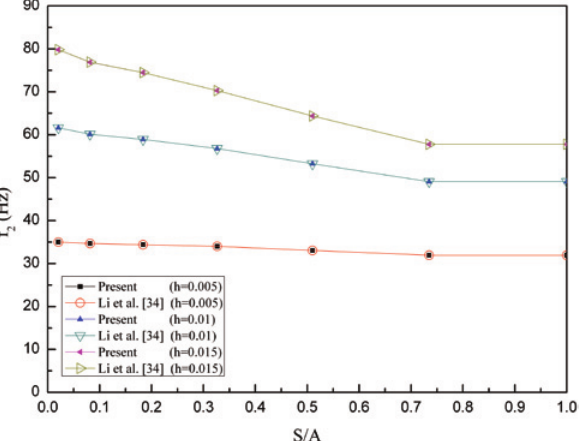
Figure 11 The second-order frequency of the clamped square com- posite laminates with different area of bonding imperfections.